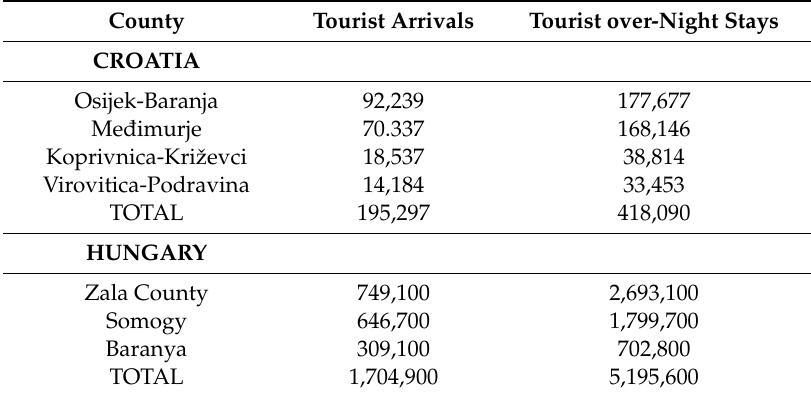
Source: Croatian Bureau of Statistics and Central Bureau of Statistics,